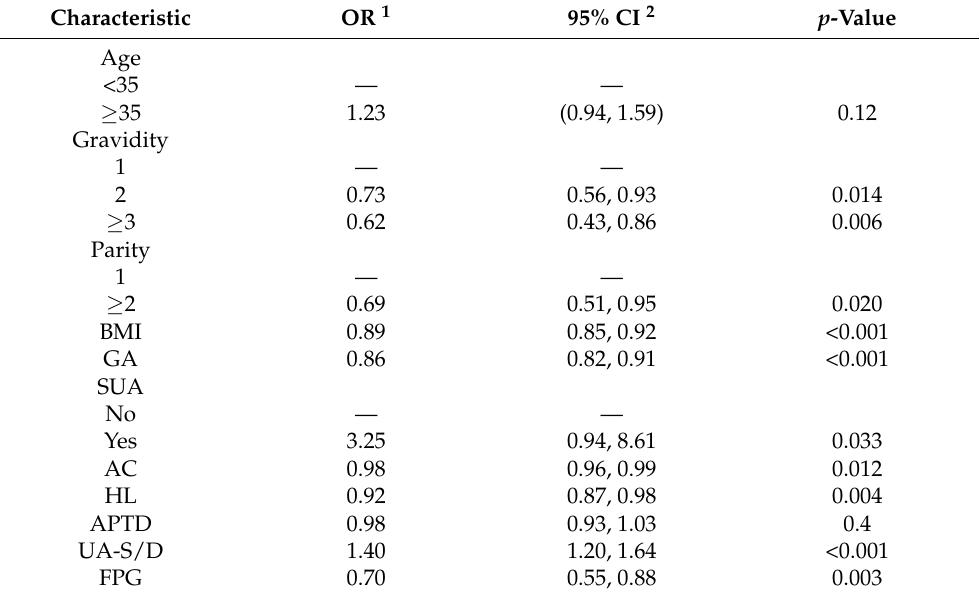
Table 3. Factors associated with SGA in women at the International Peace Maternity and Child Health Hospital (n =